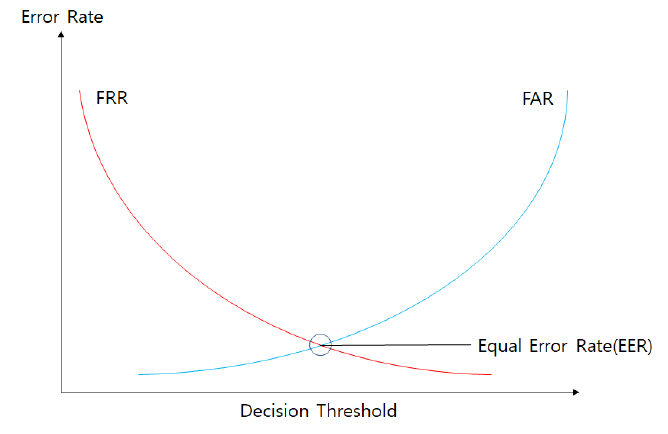
Figure 5. Equal Error Rate (EER).